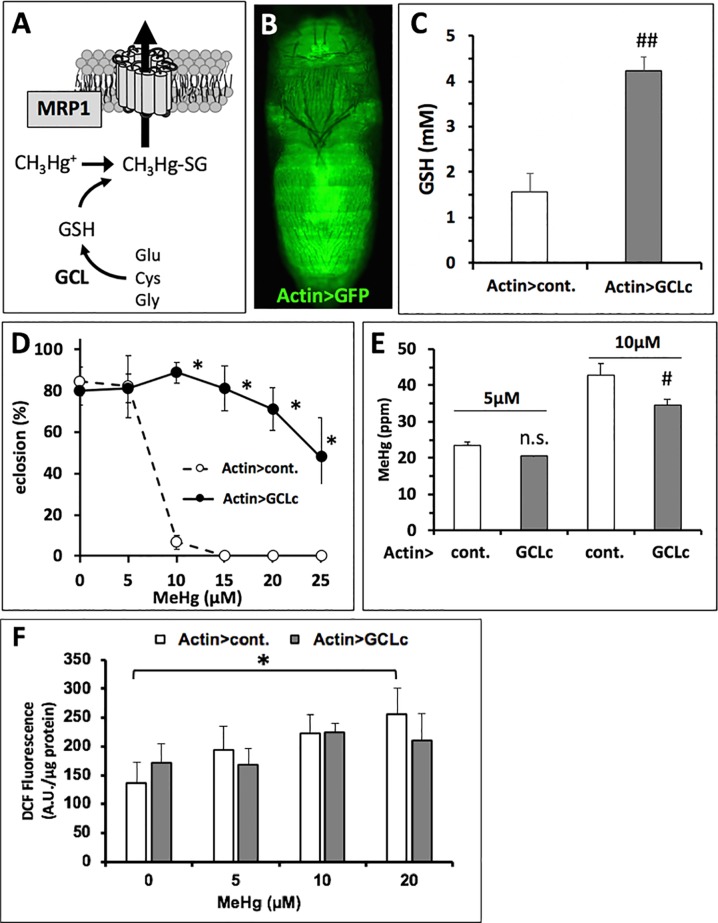
Genetic rescue of MeHg-inhibited eclosion with GCLc expression. (A) Glutamyl-cysteinyl ligase (GCL) is the rate-limiting enzyme in glutathione (GSH) synthesis. GSH conjugated to MeHg is a substrate for cellular export via the multi-drug resistance like protein transporter (MRP1) (Madejczyk et al., 2007). (B) Gal4 > UAS expression pattern of the actin promoter (ActinGAL4, Actin>) revealed with UASGFP in a late pupa. (C) Pupal GSH levels with expression of the catalytic subunit of GCL (GCLc) by the actin promoter (Actin>) compared to control (cont., the w1118 background genetic strain). GSH levels were determined in lysate preparations of whole pupae (n = 3 replicates of pooled samples of 10 pupae, ##
p < 0.0001, t-test). (D, E) Actin > GCLc and control (Actin > w1118) flies reared on indicated concentration of MeHg were evaluated for eclosion rate (D, *p < 0.0001, z-test), Hg body burden (E, #
p = 0.016, t-test), and reactive oxygen species (ROS) (F, expressed in arbitrary fluorescence units (A.U.) per microgram protein, two-way ANOVA non-significant; one-way ANOVA, Actin > cont. p < 0.05 at 20 µM MeHg only, Actin > GCLc p∼nonsignificant).